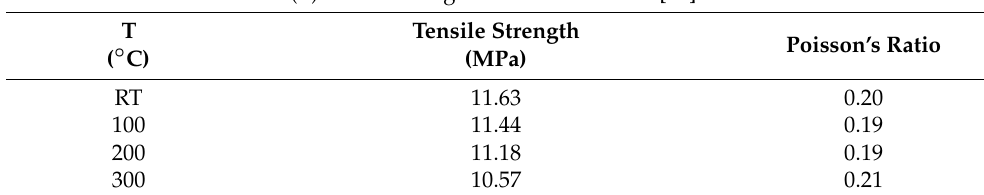
Table 1. Some key temperature-dependent mechanical properties of Fujian granite.